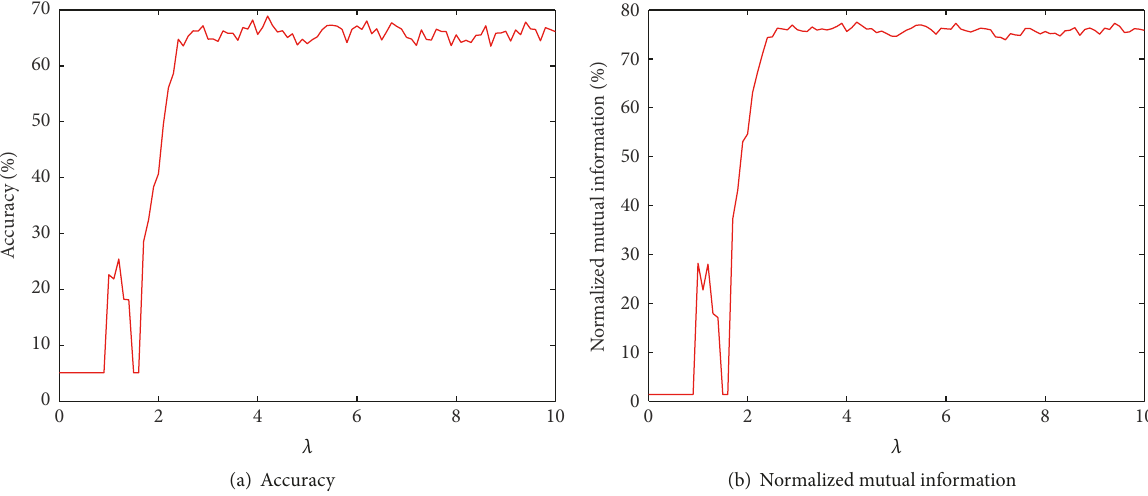
Figure 3: The performance of GSNMF versus different 𝜆 on COIL20 data set.